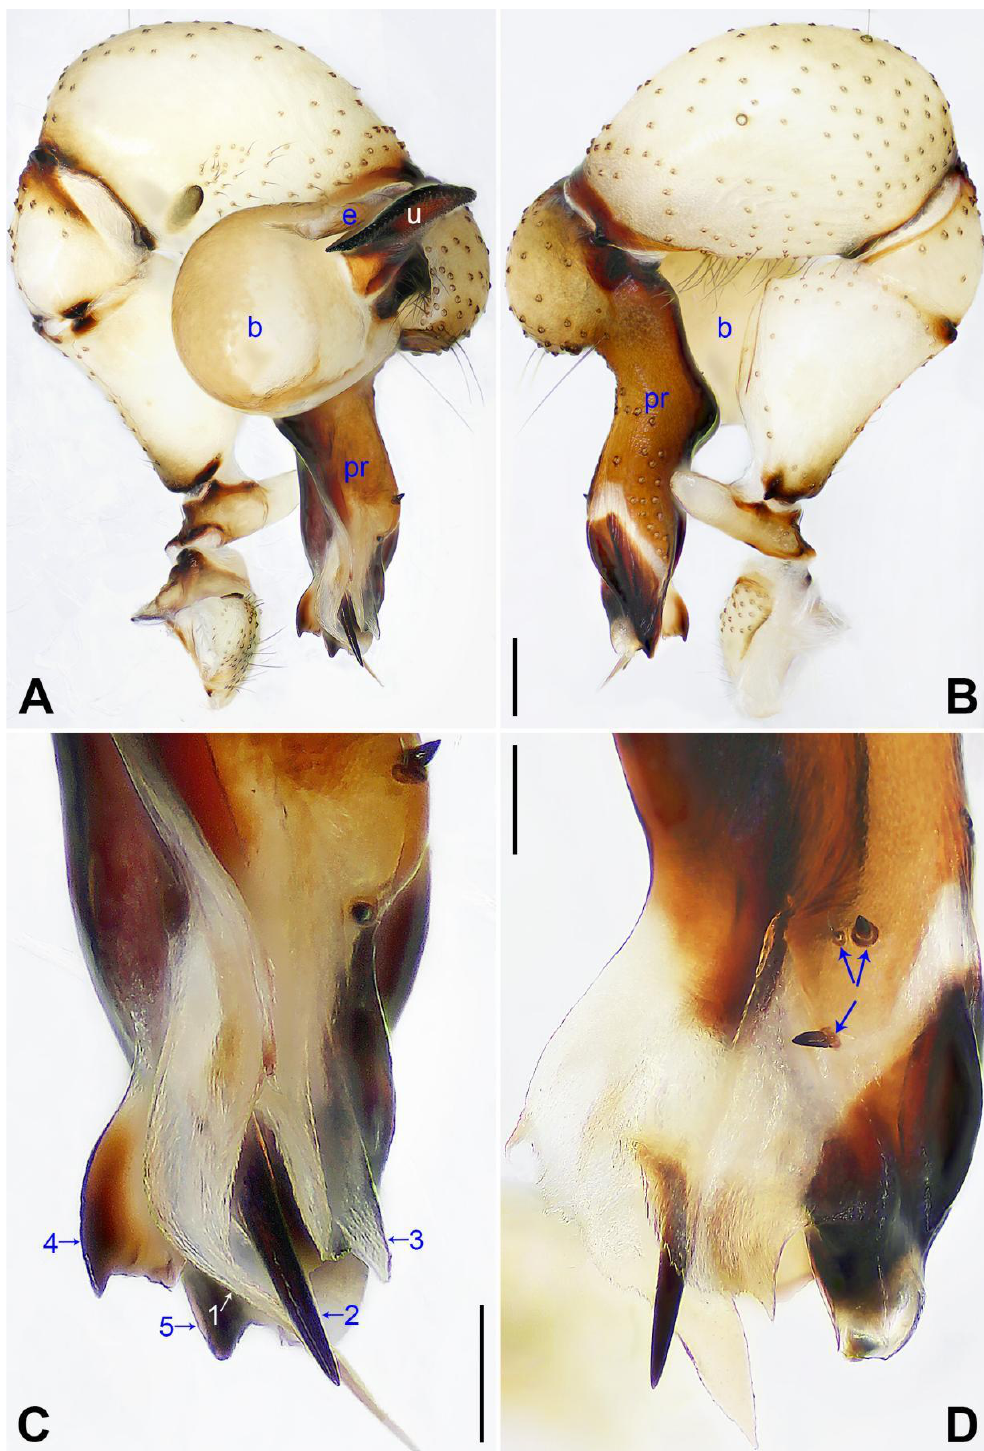
Figure 13. Pholcus xiangfen sp. nov., holotype male: ( A ) flipped right pedipalp, prolateral view; ( B ) flipped right pedipalp, retrolateral view; ( C ) distal part of flipped right procursus, prolateral view (arrow 1 points at prolateral membranous process, arrow 2 points at spine-shaped distal apophysis, arrow 3 points at dorsal membranous lamella, arrows 4, 5 point at ventro–subdistal and ventro–distal apophyses, respectively); ( D ) distal part of flipped right procursus, dorsal view (arrows point at dorsal spines). b = bulb, e = embolus, pr = procursus, u = uncus. Scale bars: ( A , B ) = 0.20 mm; ( C , D ) = 0.10 mm.